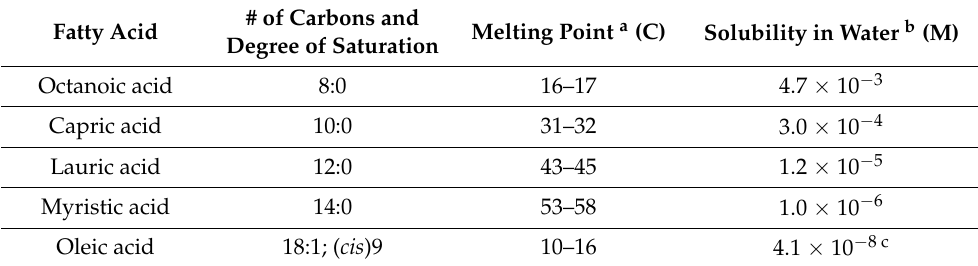
Table 2. Physical and solution properties of the studied fatty